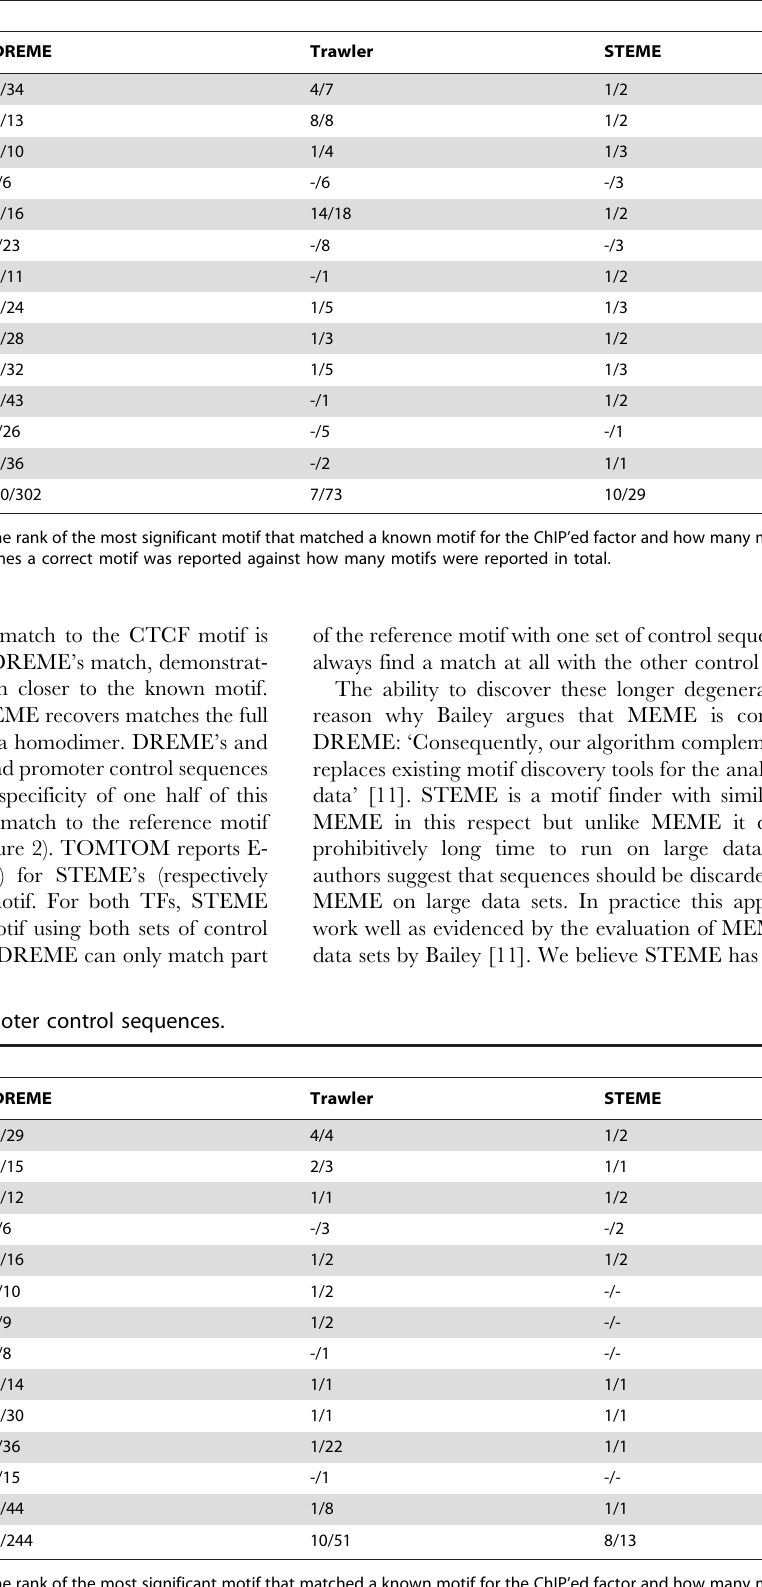
Table 1. Results using the dinucleotide-shuffled control sequences.